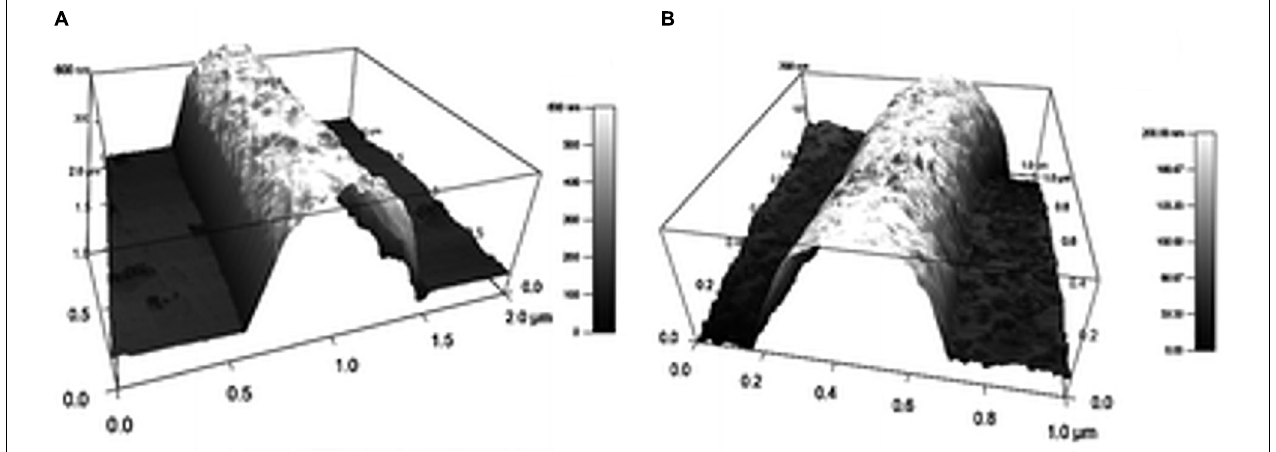
FIGURE 5 | AFM images of activated carbon fibers from blend fibers of (alkali lignin/PEO: 9/1) activated with (A) NaOH, and (B) KOH. The fibers were carbonized at 850 ◦ C for 0.5 h in nitrogen. Reproduced from Hu and Hsieh (2013) with permission from The Royal Society of Chemistry (Order license ID